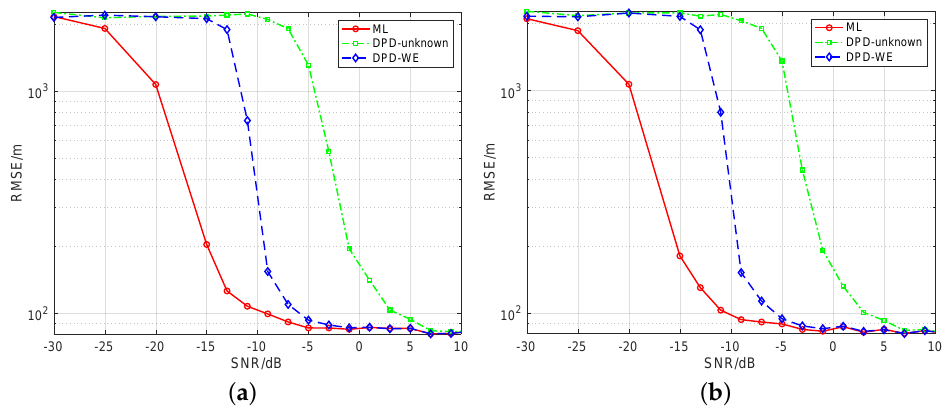
Figure 10. RMSE vs. SNR for the three localization algorithms of ML, DPD-unknown and DPD- WE with transmitting rectangle pulses of noncoherent and coherent modulations: ( a ) noncoherent modulation, ( b ) coherent